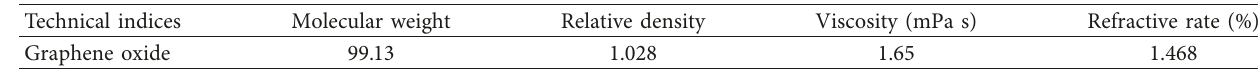
Table 4: Technical capacities of